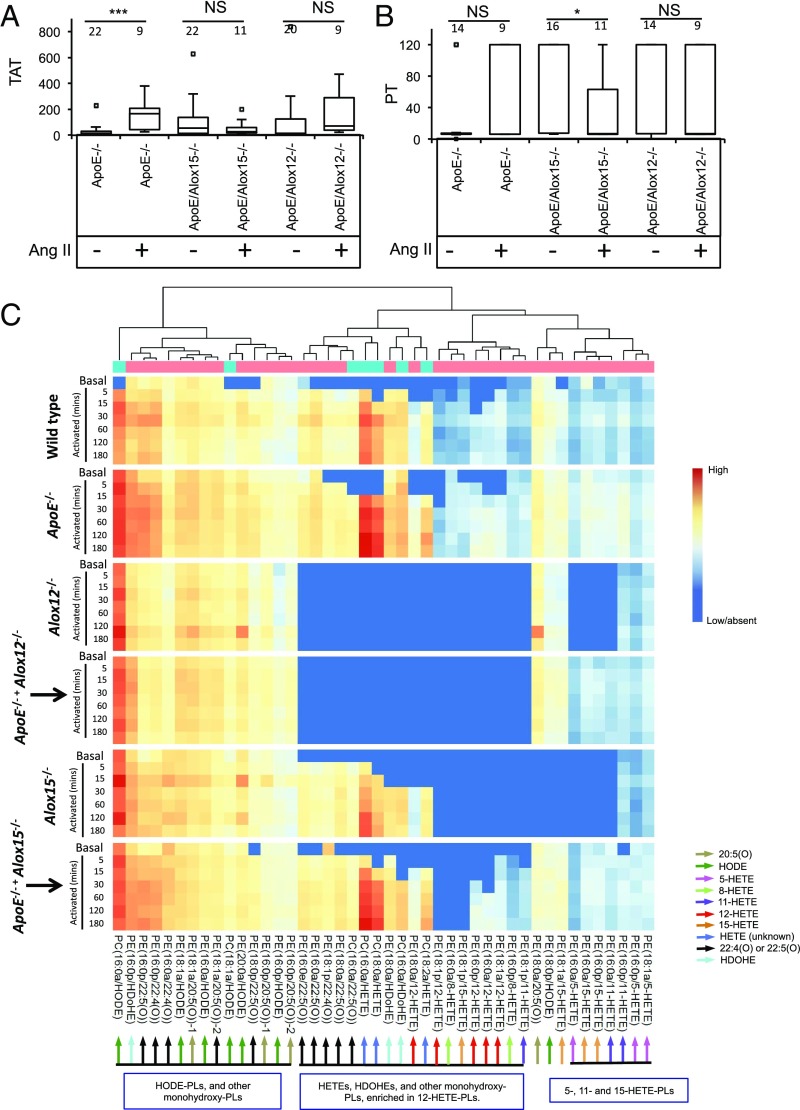
Ang II infusion induces consumptive coagulopathy in mice, while ApoE and Alox deletion is associated with major changes in eoxPL profile. (A) Ang II increases plasma TATs in mice. ApoE−/−, ApoE−/−/Alox12−/−, and ApoE−/−/Alox15−/− 19- to 24-wk-old male mice maintained on a normal chow diet were infused with Ang II for 2 wk. TATs were measured by ELISA. (B) PT of plasma in response to 2-wk infusion of Ang II with/without liposomes. ApoE−/−, ApoE−/−/Alox12−/−, and ApoE−/−/Alox15−/− 19- to 24-wk-old male mice maintained on a normal chow diet were administered Ang II for 2 wk. PT was measured as per Materials and Methods. Data were analyzed using Mann–Whitney nonparametric u test and shown on box plots (median, with whiskers representing interquartile range), ***P < 0.001, *P < 0.05. (C) Oxylipidomics of blood clotting from all mouse strains. Blood was harvested and induced to clot as in Materials and Methods. Lipids were extracted from clots and profiled using LC/MS/MS. Heatmaps were generated using Pheatmap (n = 3 per sample) using log10 data values as described in SI Appendix, SI Materials and Methods.